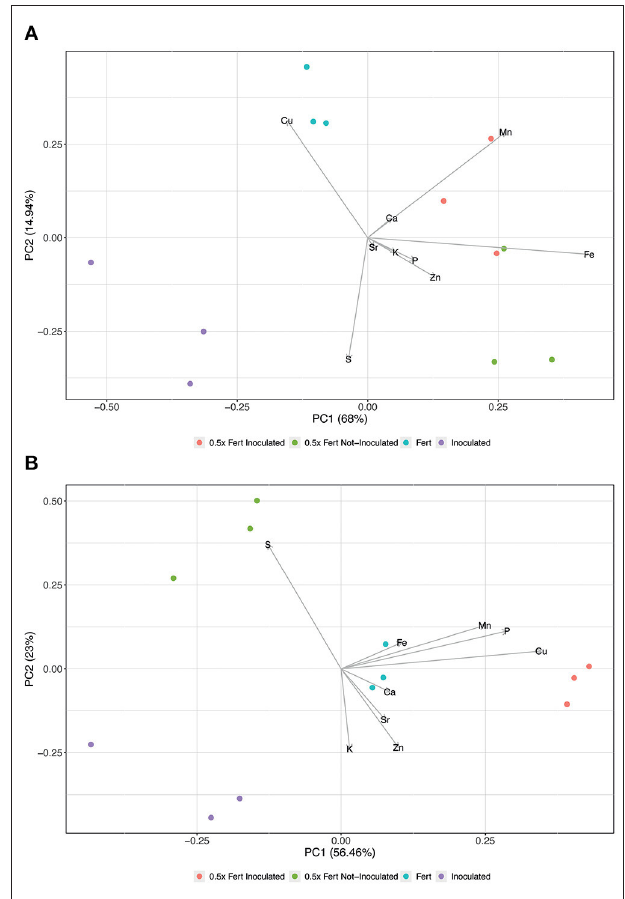
FIGURE 4 | Principal Component Analyses of ionomic datasets. (A) Scatterplot representing the modification of root ionome in cucumber plants harvested after 60 days of cultivation in greenhouse and subjected to the different fertilization treatments (i.e., Inoculated, 0.5x Fert Not-Inoculated, 0.5x Fert Inoculated, and Fert). (B) Scatterplot representing the modification of shoot ionome in cucumber plants harvested after 60 days of cultivation in greenhouse and subjected to the different fertilization treatments (i.e., Inoculated, 0.5x Fert Not-Inoculated, 0.5x Fert Inoculated, and